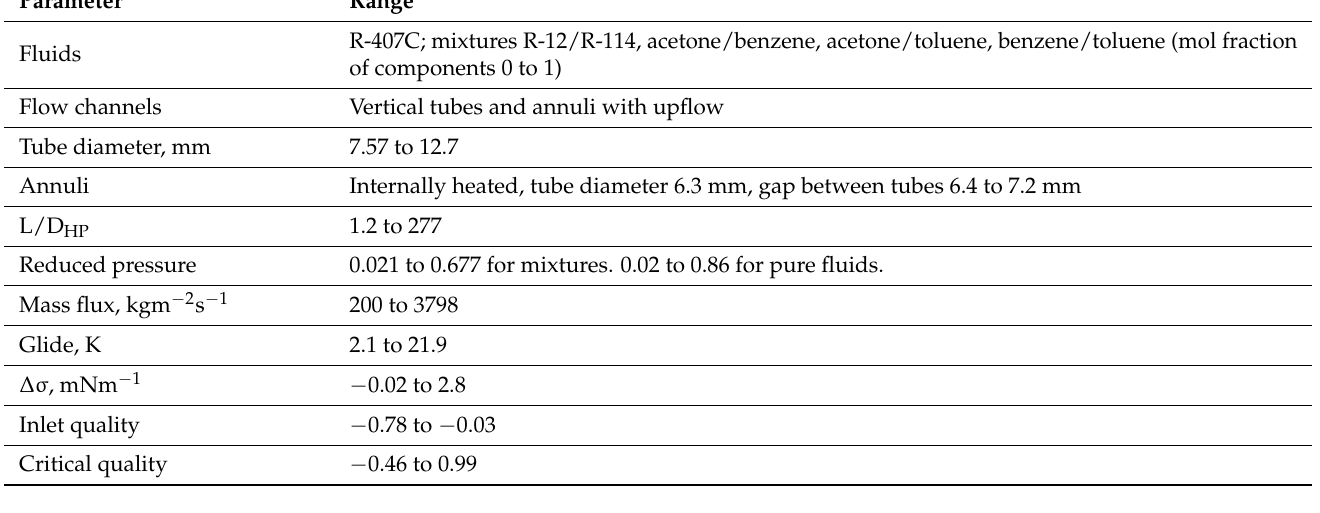
Table 3. Range of parameters in the data